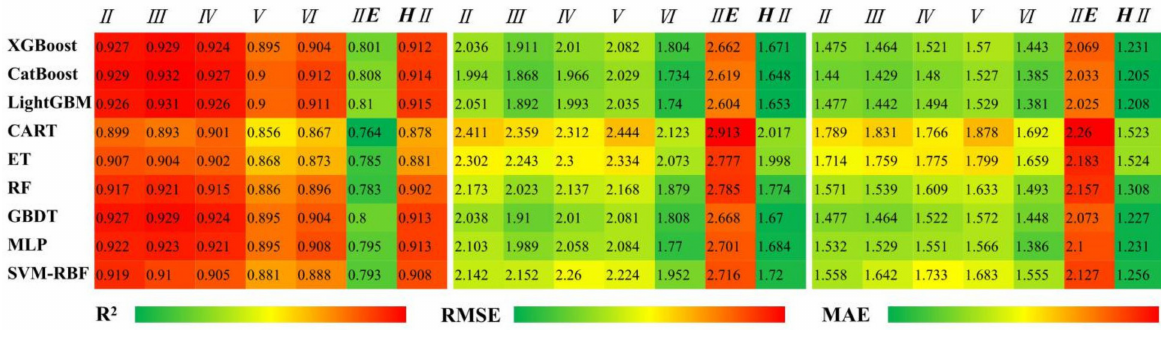
Figure 6. The R 2 , RMSE and MAE in different temperate